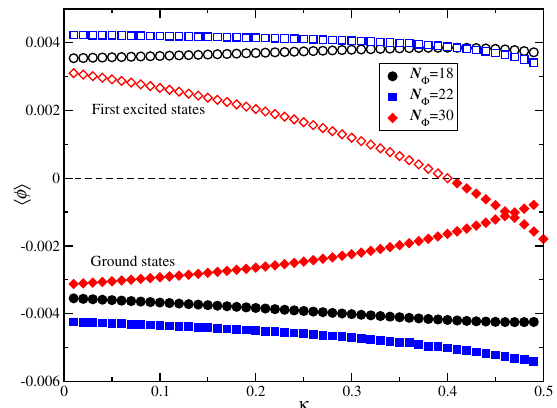
FIG. 10. The expectation value of a particle-hole-antisymmetric order parameter ϕ for the ground state and first excited state of Eq. (2) on the torus using the hexagonal unit cell for N Φ ¼ 18 , 22, and 30 as a function of κ for w= l 0 ¼ 0 . The ground state is consistent with the MR state and has h ϕ i < 0 (filled symbols), while the first excited state is consistent with the aPf state with h ϕ i > 0 (open